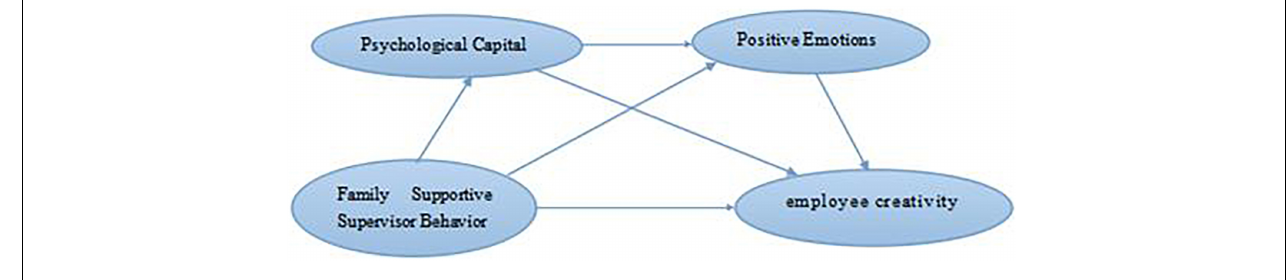
FIGURE 1 | Research